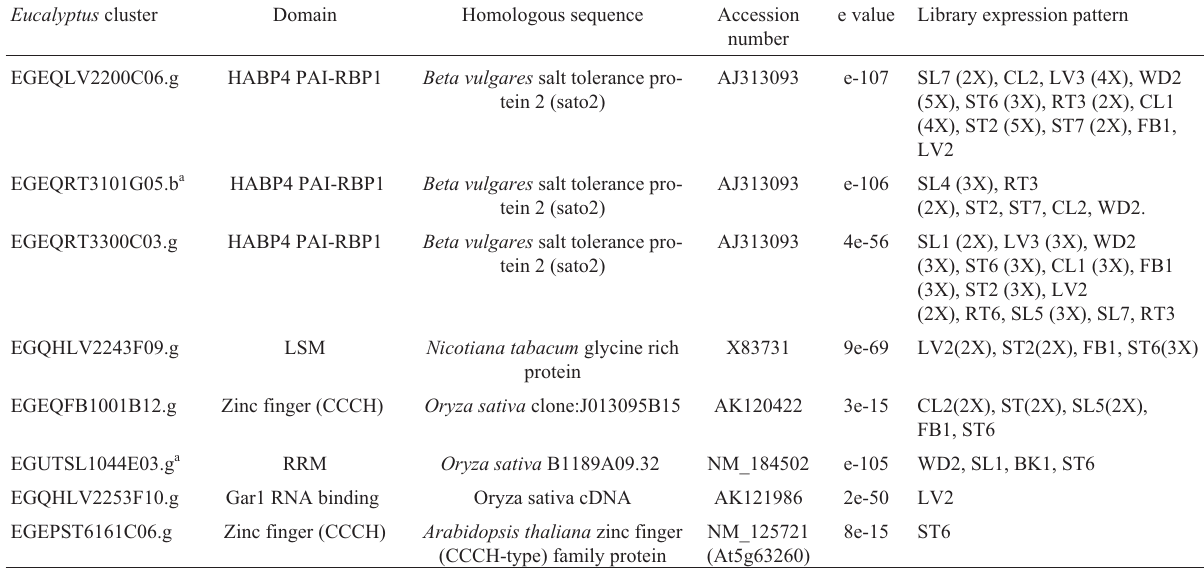
Table 9 - Eucalyptus ESTs with GRPs that present other conserved domains usually found in RNA-binding proteins. Eucalyptus